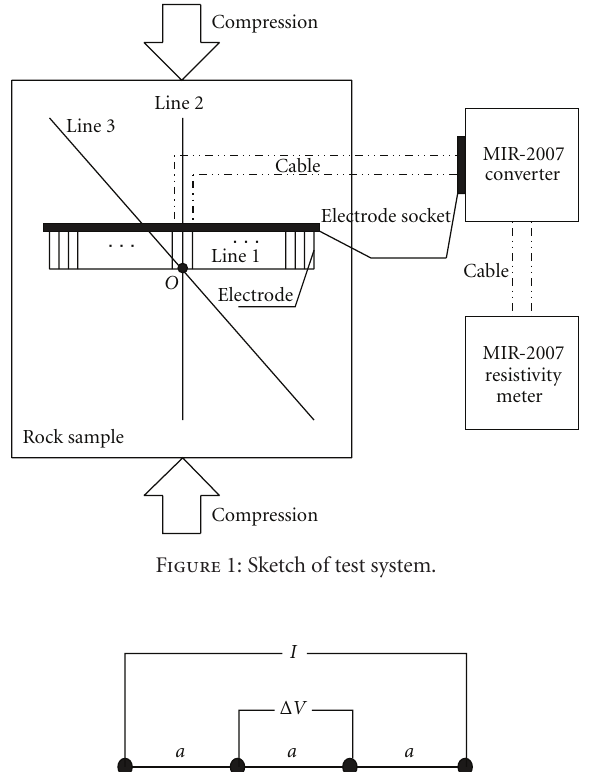
Figure 1: Sketch of test system.